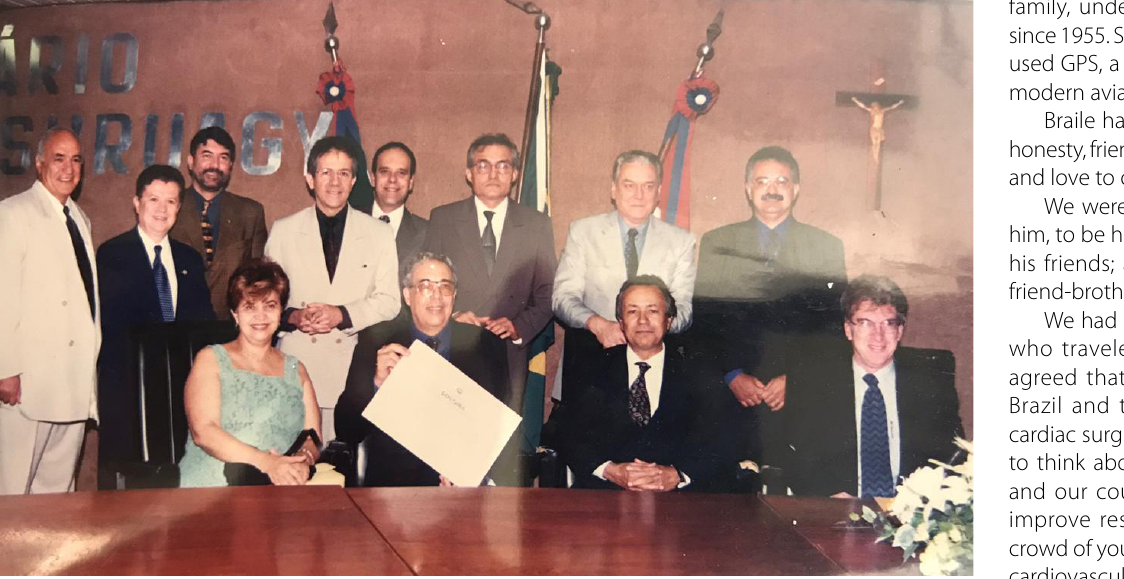
Fig. 1 – Domingo Braile receiving the title of honorary citizen of Alagoas in the company of colleagues and friends.